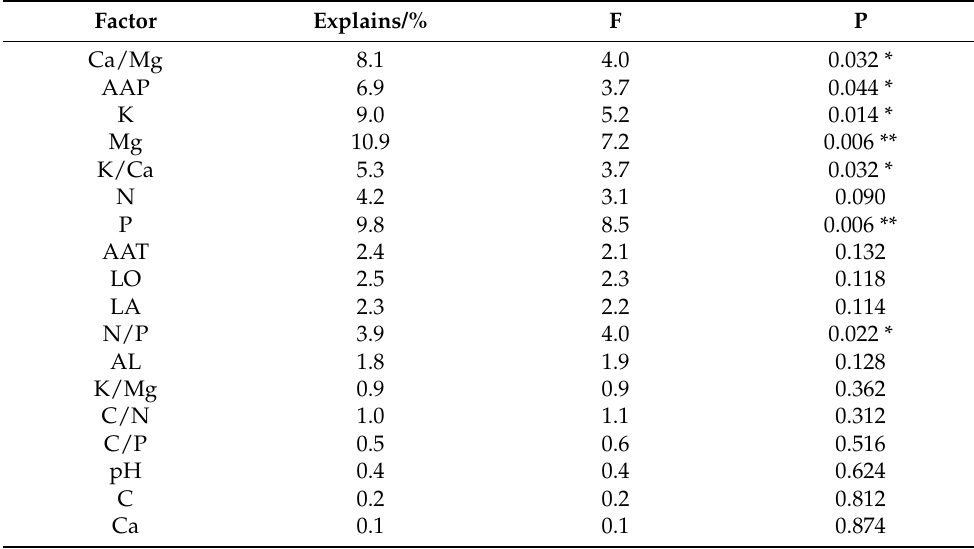
Table 2. Redundancy analysis of environmental factors on bacterial α -diversity by permutationtest ( p < 0.05) using Canoco 5.0. Factor